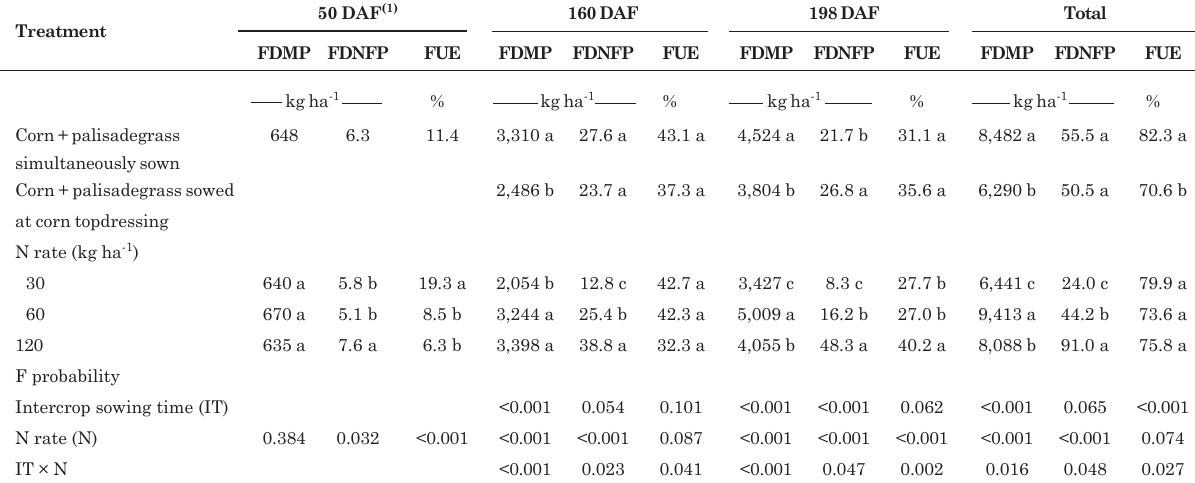
Table 1. Forage dry matter production (FDMP), amount of fertilizer-derived N in the forage plant (FDNFP), and fertilizer use efficiency (FUE) by palisade grass sown in intercrops with corn at two times and fertilized with N rates (source 15 NH 4 NO 3 ) applied after corn grain harvest and evaluated at three sampling times (50, 160 and 198 days after fertilization - DAF) and